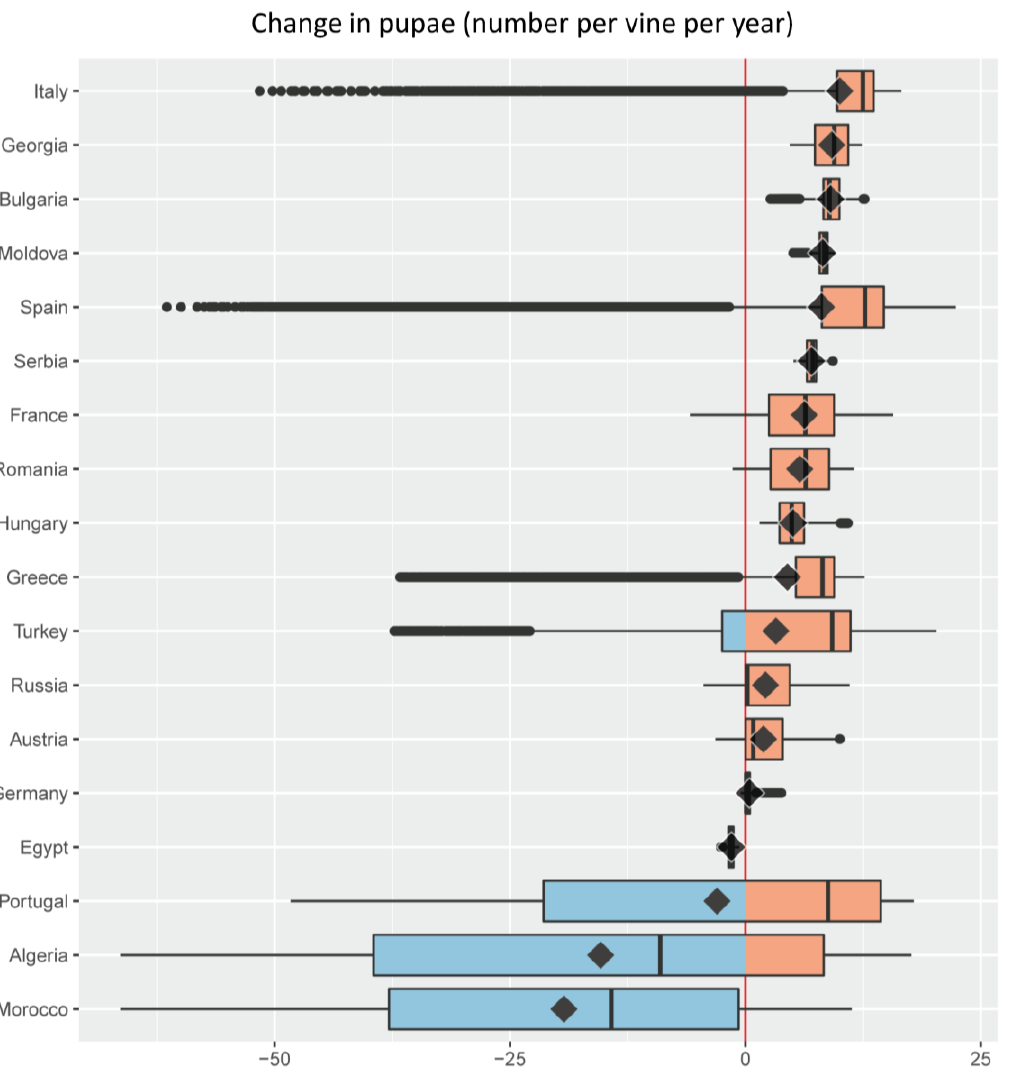
Figure 6. Change in the density of the grapevine moth Lobesia botrana (cumulative number of pupae per plant per year) under an A1B scenario of 1.8 °C average climate warming in the Euro-Mediterranean region illustrated as a series of stacked boxplots (graphics produced using the R package ggplot2 [72]), one for each of the 18 Euro-Mediterranean countries (Figure 2) having a grape growing area larger than 32 × 10 3 ha [67]. Box-and-whisker plots (boxplots) indicate the distribution of data with the vertical black line inside the box representing the median value, the left and right limits of the box being the 25th and 75th percentile (the lower and upper quartiles, respectively), and the whiskers indicating the minimum and maximum value unless outliers are shown as black points, in which case whiskers represent the lower quartile − (1.5 × the interquartile range) (IQR, a measure of statistical dispersion equal to the difference between upper and lower quartiles) and/or the upper quartile + (1.5 × IQR). The superimposed diamonds indicate the mean climate change impact, and boxplots are ordered using this parameter. The red line is a reference for no impact with blue filling indicating a negative change (decrease) and pink a positive one (increase). Color palette from ColorBrewer [73].